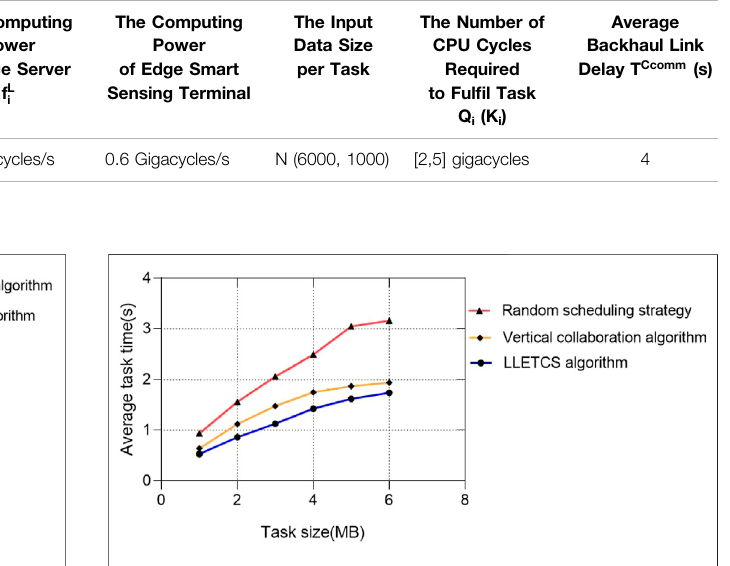
FIGURE 5 | Effect of task